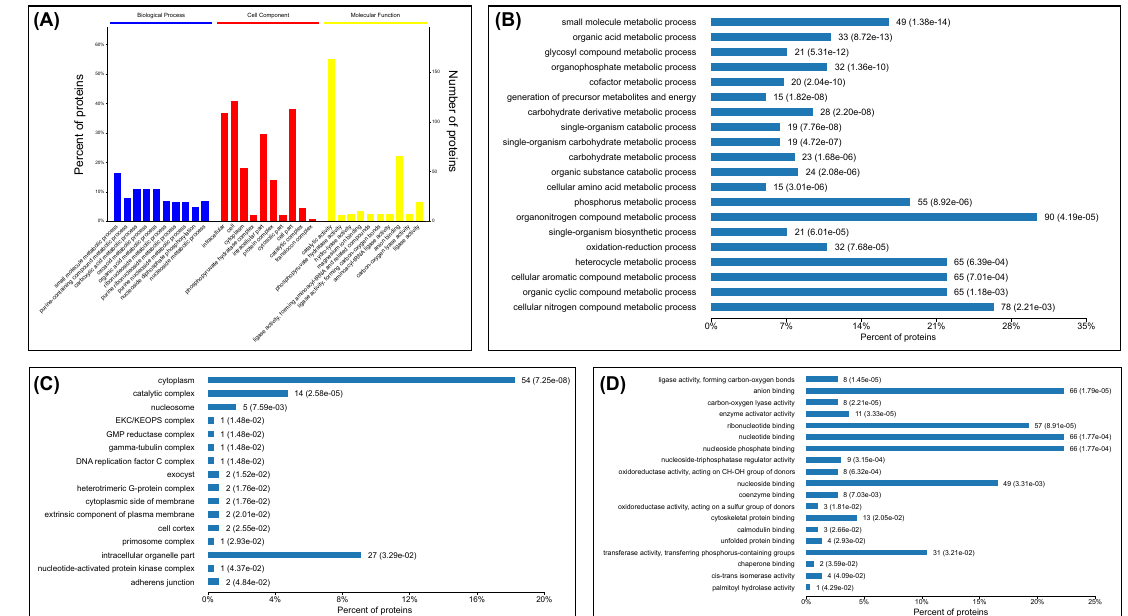
Figure 4. GO enrichment analysis of statistically significant DEPs in SVA-infected cells at 12 hpi. Top 10 statistically significant GO terms of three categories (biological process, cell component and molecular function) ( A ). Major GO terms that are significantly enriched in biological processes ( B ), cell component ( C ), and molecular function ( D ). Each bar is followed by the number of DEPs with the corresponding p